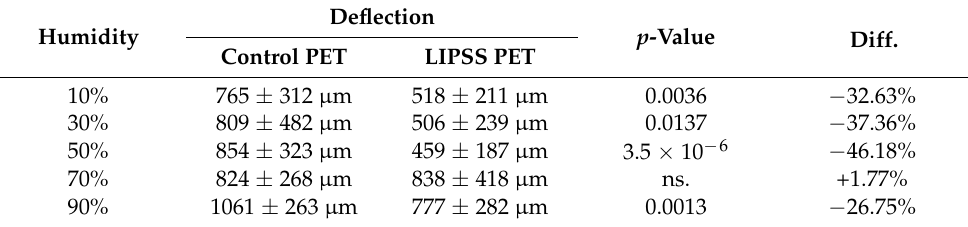
Table 1. Indirect measurement of the adhesion (by deflection) of the threads at different humidity levels, presented as mean ± SD and the relative change between control and structured surface (Diff.). Significance was calculated using a Wilcoxon t -test, with p <